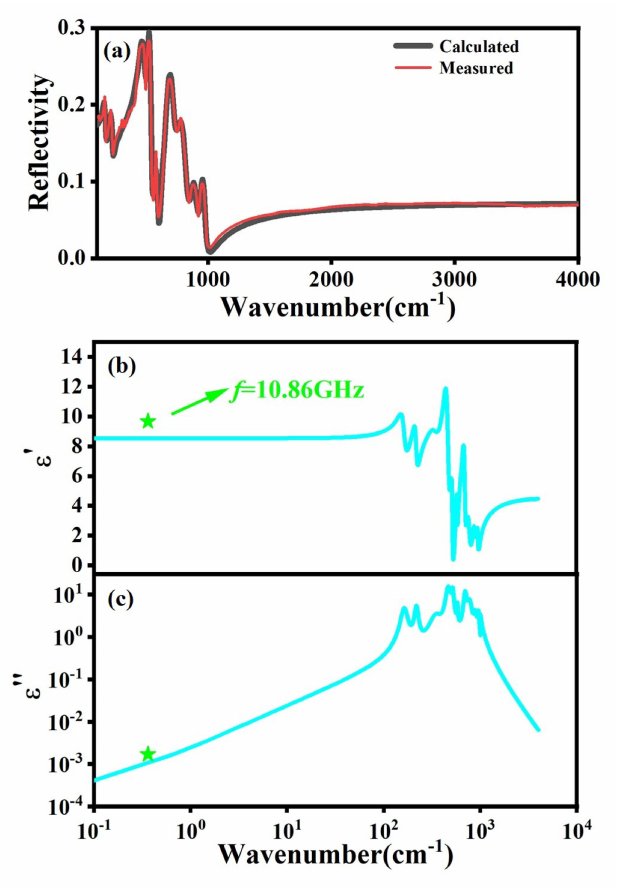
Figure 8. ( a ) Fitted and experimental infrared reflection spectrum of Y 2.95 Dy 0.05 MgAl 3 SiO 12 ceramic and ( b , c ) fitted complex dielectric spectrum in the microwave